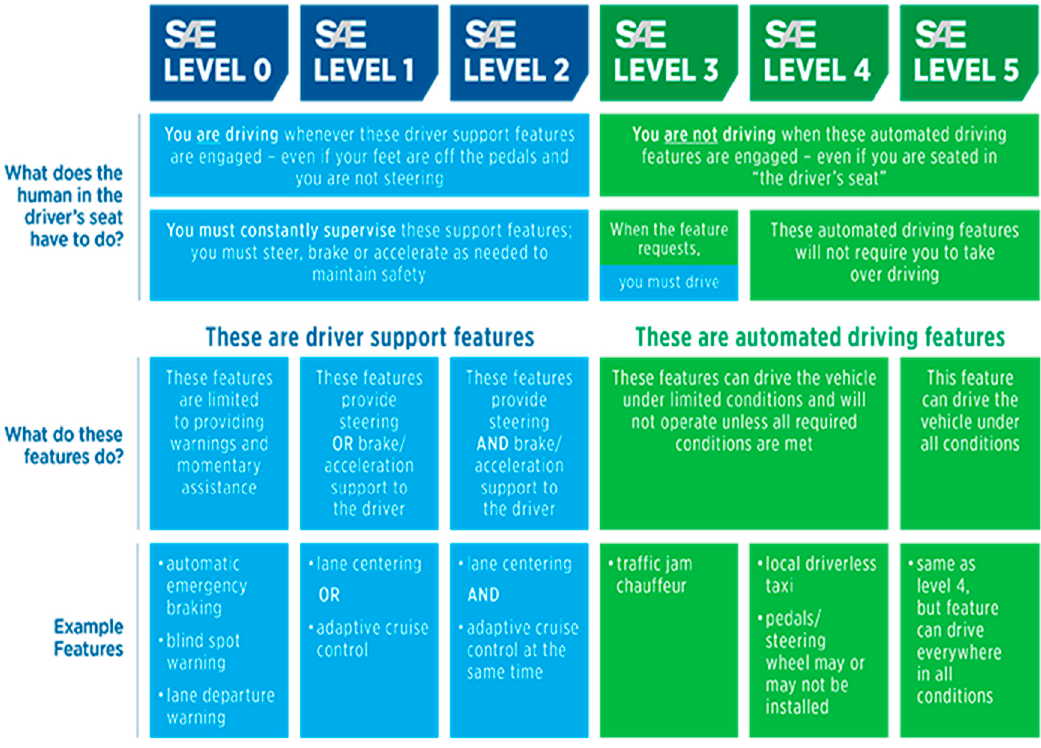
Figure 3. Vehicle automation levels.